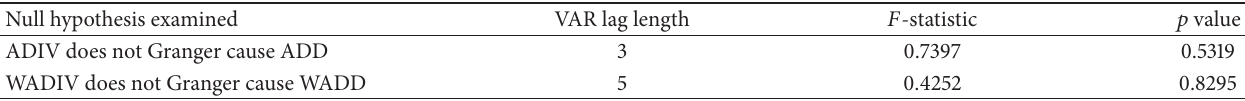
Table 2: Linear Granger causality tests.